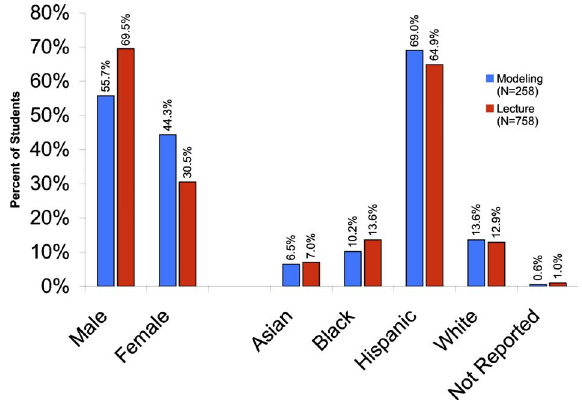
FIG. 2. (cid:1) Color (cid:2) Demographics of Introductory Physics, there were ten Native American students in the lecture-format data that are not represented in